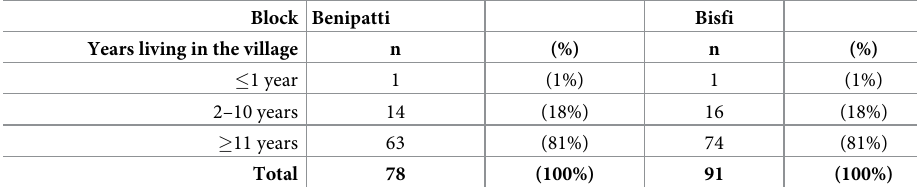
Table 3. Years of residence of leprosy index cases by block.